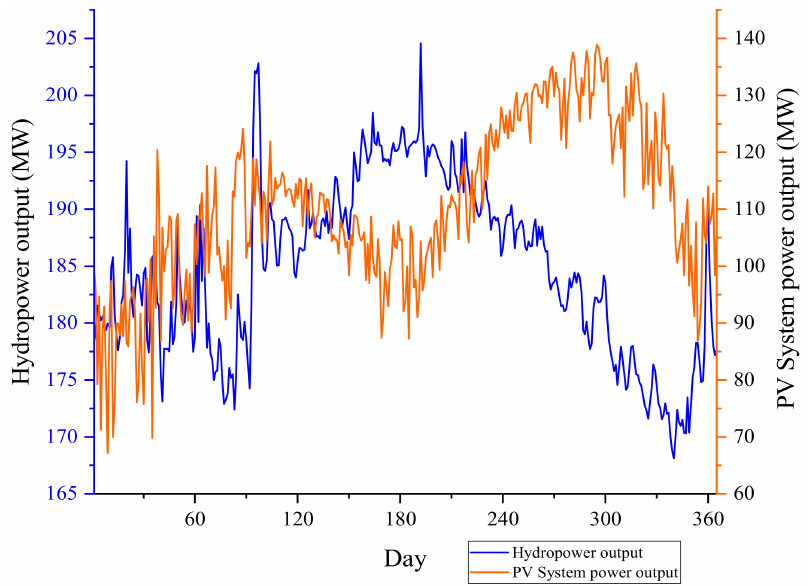
Figure 6. Complementarity of hydro and solar PV power output throughout the year in rainy and dry